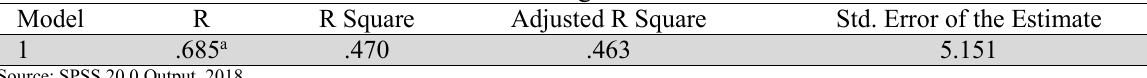
The result of determinant Coefficient of the results given in Table 3 Model